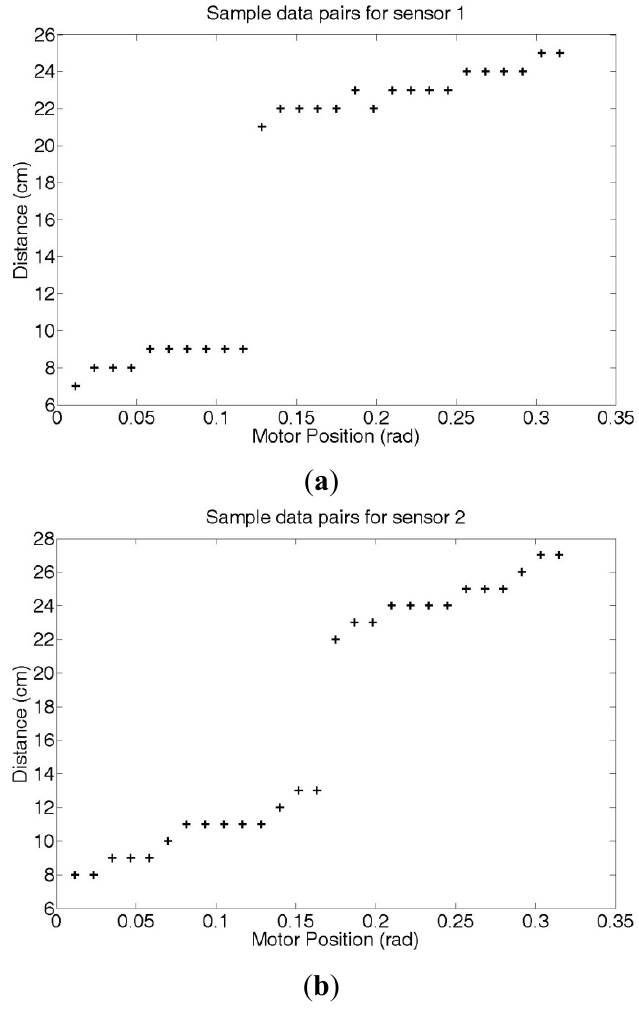
Figure 9. Sample motor position and measured distance data pairs for a training procedure of the new regression method for ( a ) sensor 1 ( b ) sensor